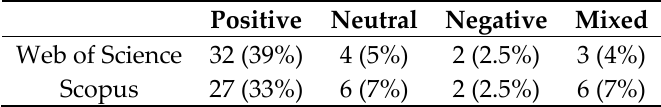
Table 2. A summary of the influence CSP on CFP in the 82